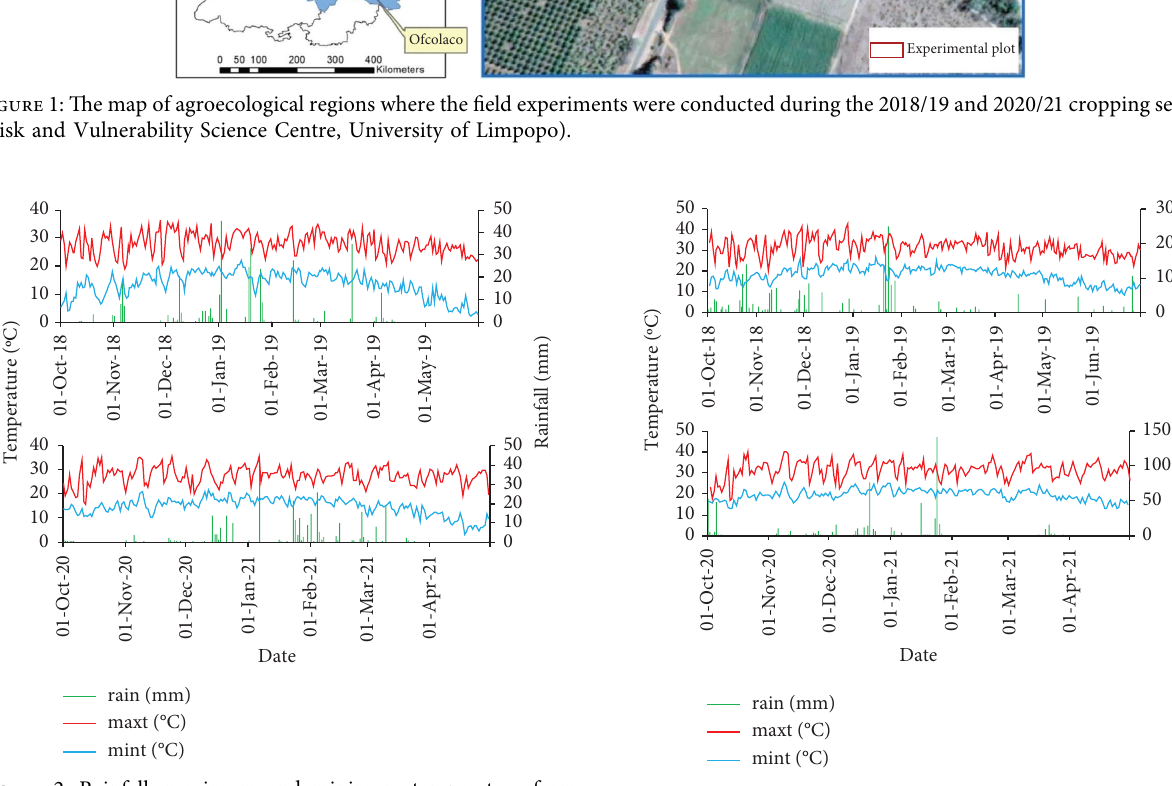
Figure 3: Rainfall, maximum and minimum temperature at Ofcolaco during the 2018/19 and 2020/21 cropping